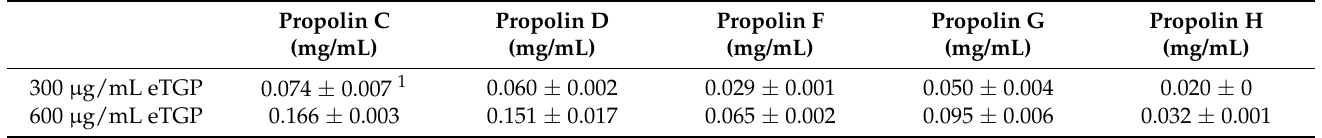
Table 6. Determination of propolin contents in